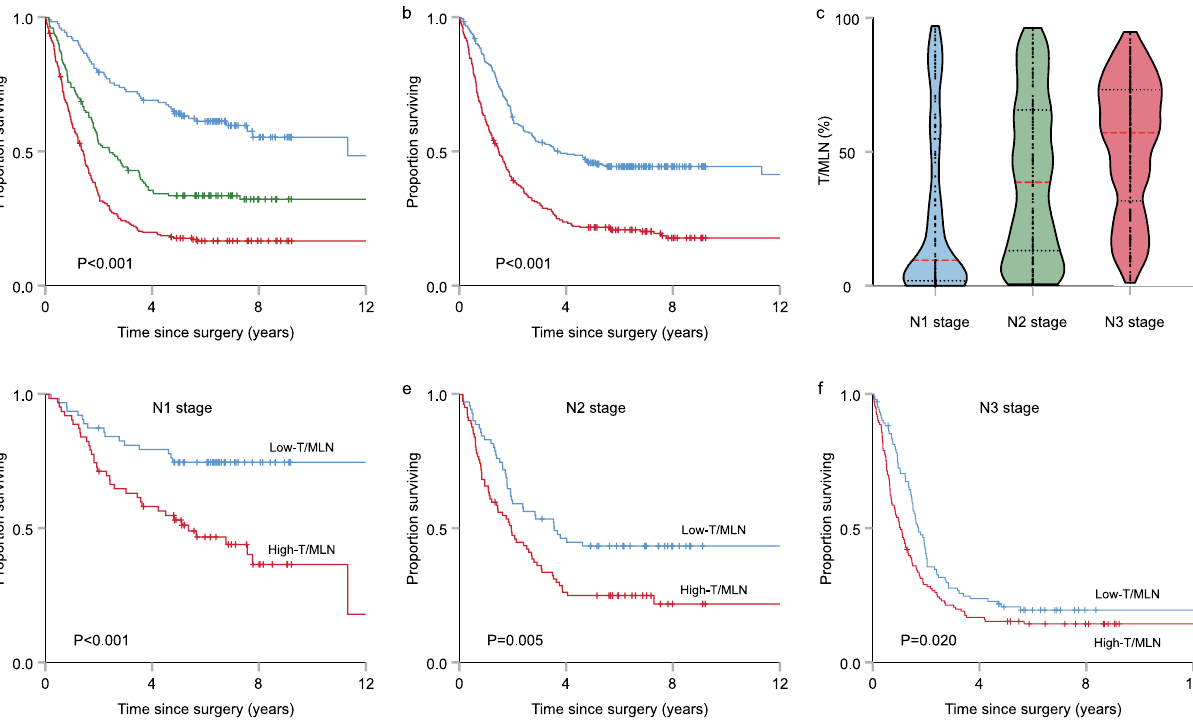
Fig. 4 Kaplan – Meier analysis of cancer-speci fi c survival and distribution statistics of T/MLN in the N stage with low-T/MLN and high-T/MLN at the CH Hospital 2001 – 2005 cohort. a KM curve with the N stage. b KM curve with the T/MLN. c Distribution of T/MLN with the N stage ( n = 127 patients at N1 stage; n = 153 patients at N2 stage; n = 236 patients at N3 stage). In the violin plot, red lines indicate the median. d KM curve at N1 stage. e KM curve at N2 stage. f KM curve at N3 stage. P values were determined by two-sided log-rank test.